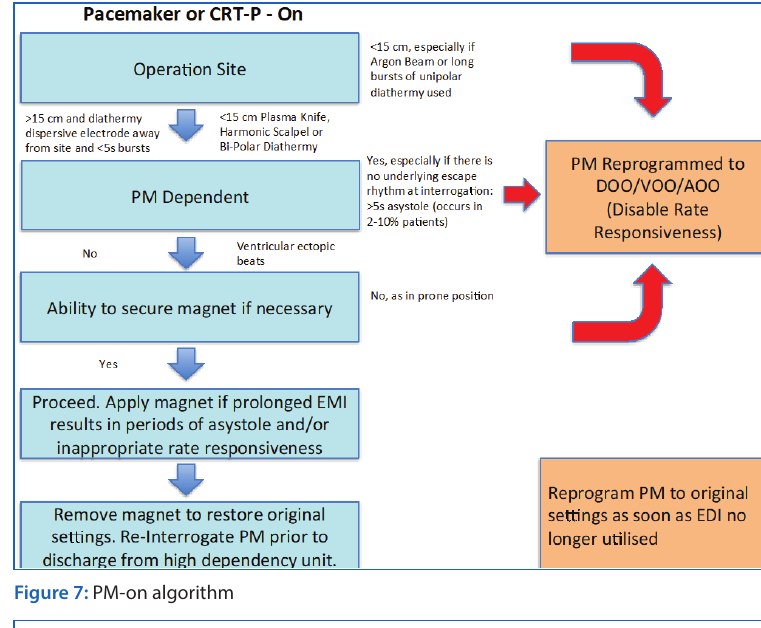
Figure 7: PM-on algorithm